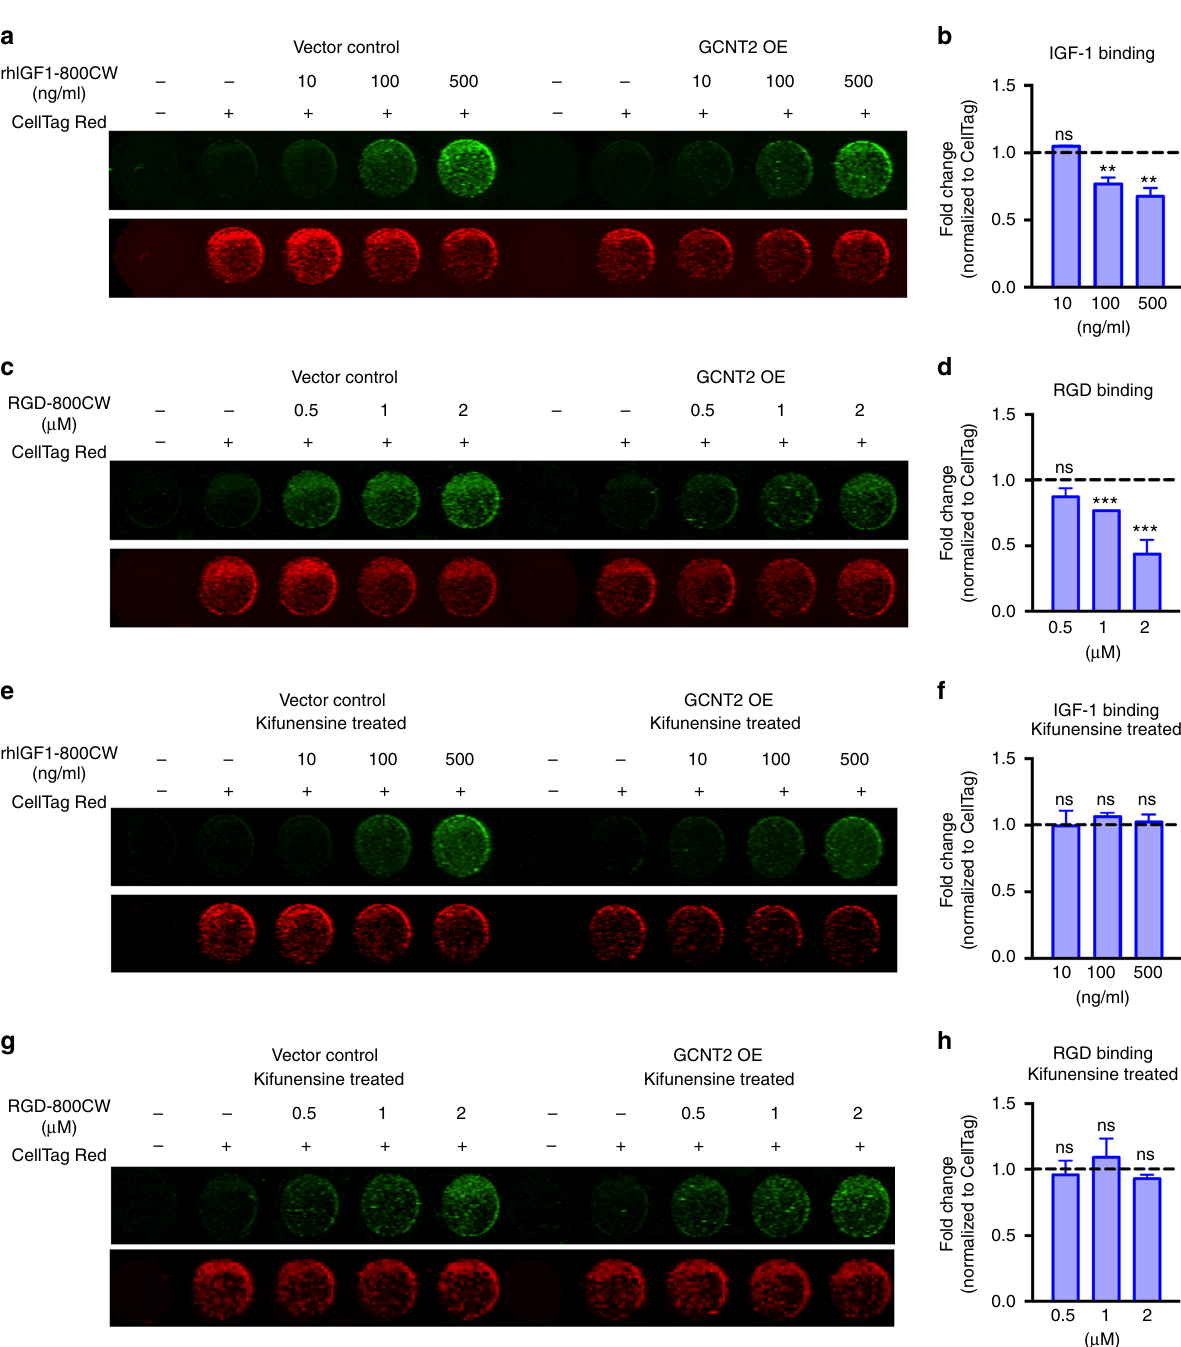
Fig. 7 GCNT2 decreases IGF-1 and RGD-peptide ligand binding activity. a , b Representative images ( a ) and quantitation ( b ) of rhIGF1-800CW binding activity to A375 vector control and GCNT2 OE cell variants. c , d Representative images ( c ) and quantitation ( d ) of RGD-800CW binding activity to A375 vector control and GCNT2 OE cell variants. e , f Representative images ( e ) and quantitation ( f ) of rhIGF1-800CW binding activity to kifunensine treated A375 vector control and GCNT2 OE cell variants. g , h Representative images ( g ) and quantitation ( h ) of RGD-800CW binding activity to kifunensine- treated A375 vector control and GCNT2 OE cell variants. Quantitation of rhIGF1-800CW and RGD-800CW binding activity was normalized to total protein expression using CellTag700 Red Dye and then compared to control cells denoted by dashed line. Statistical analyses were done using unpaired two-tailed Student ’ s t test. Results are representative of n = 3 experiments (mean± SEM; ** p < 0.01; *** p <